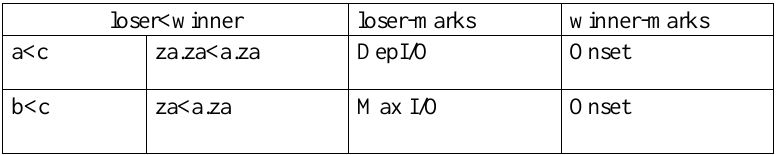
Table I – Constraint violations in zaza<a.za and